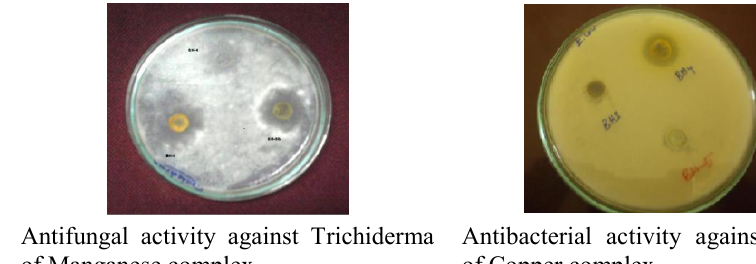
Figure 4. Antimicrobial